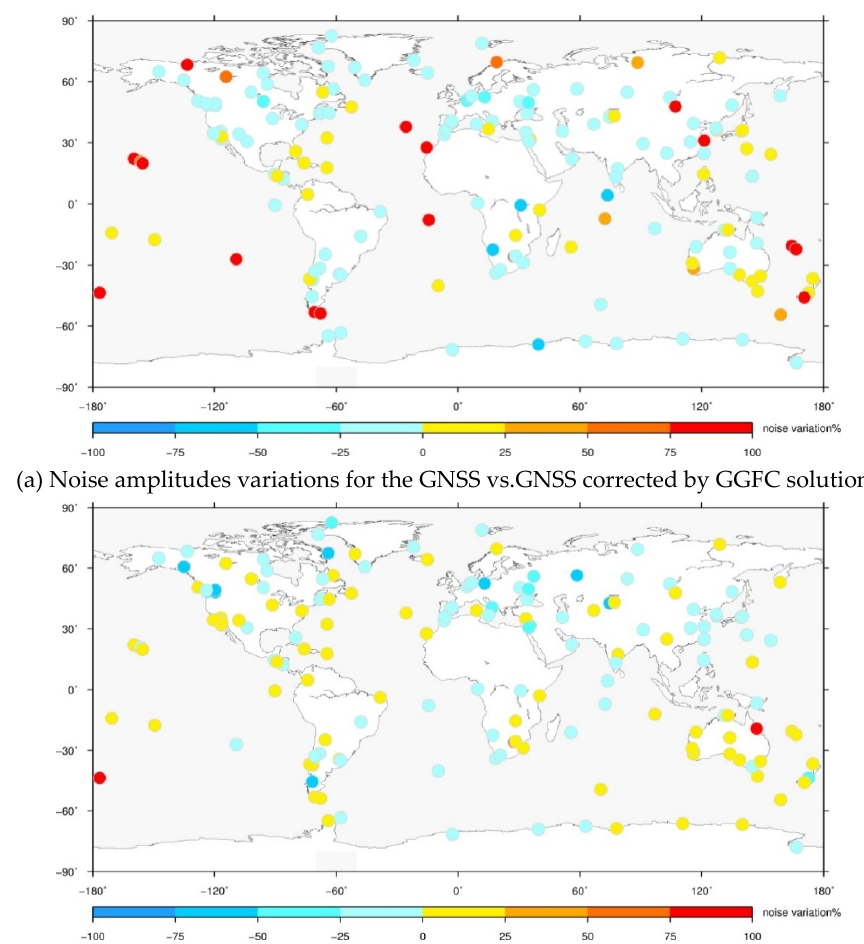
Figure 8. Noise amplitudes variations for the GNSS vs.GNSS corrected by GGFC solutions (up panel) and GNSS vs. GNSS corrected by GRACE solutions (bottom panel)